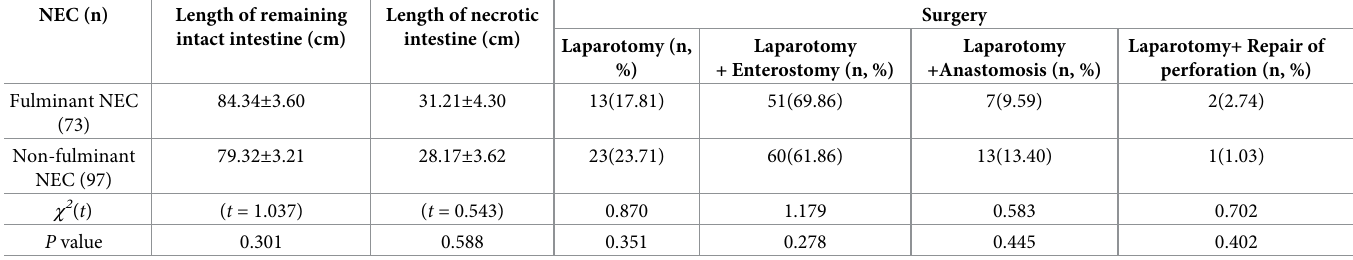
Table 3. Surgical findings of the NEC